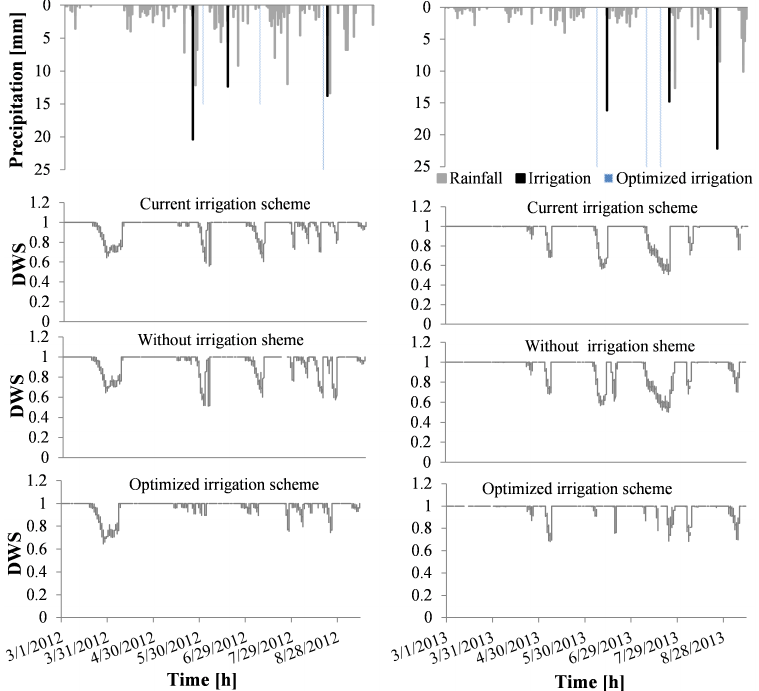
Figure 7. Comparison degree of water stress between farmer’s conventional irrigation (current irrigation), without irrigation and optimized irrigation scheme for calibration and validation periods.